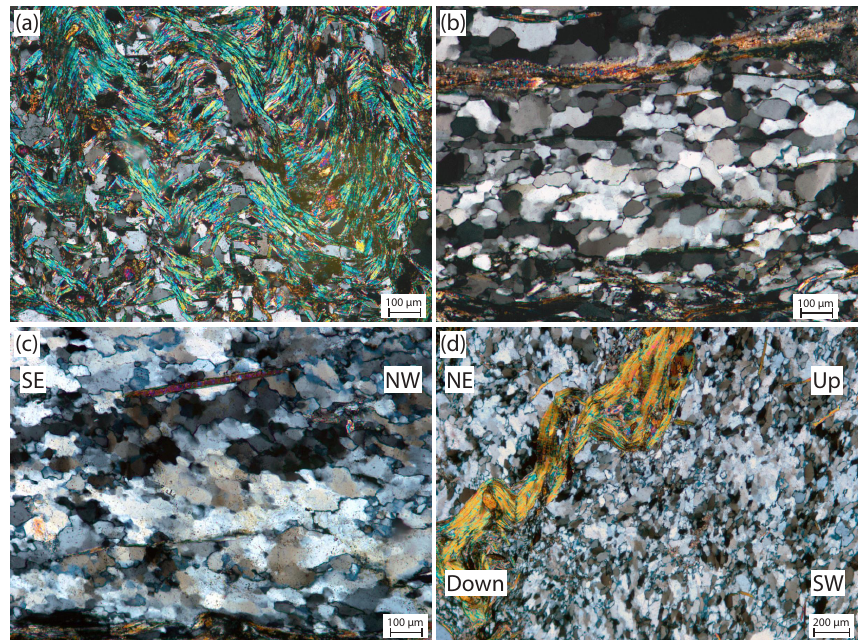
Figure 8. (a) D3 crenulations in Sample PS32 from the hinge of the Narrows synform. (b) Recrystallized quartz close to the hinge of the Narrows synform. Sample PS52. (c) Quartz in a mylonitized metagreywacke sample (PS36). (d) Lineation-perpendicular view of the myloni- tized metagreywacke. S3 defined by the crenulated white mica is sub-vertical, and so is the quartz shape preferred orientation. Sample PS35. See Fig. 2a and Table S1 for sample